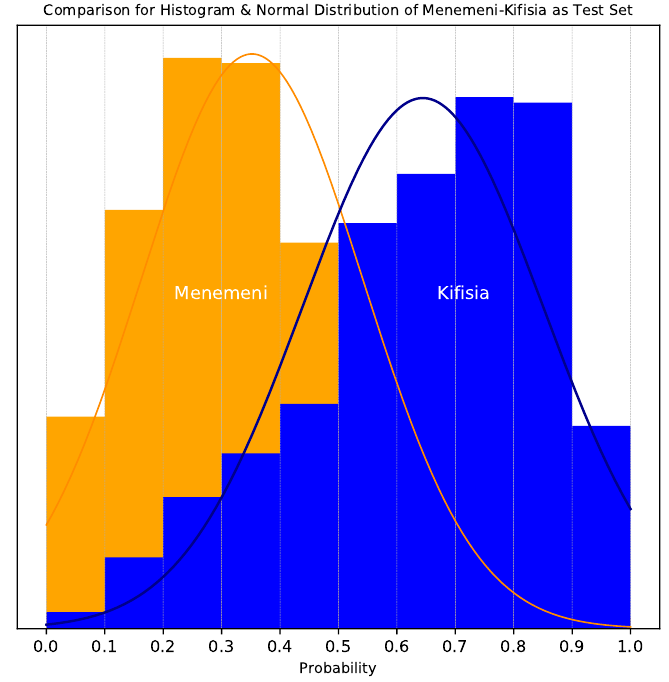
Figure 3. Classifier score distribution for cars in municipalities of Kifisia in Athens (unemployment rate: 10.8%) and Ampelokipoi/Menemeni in Thessaloniki (unemployment rate: